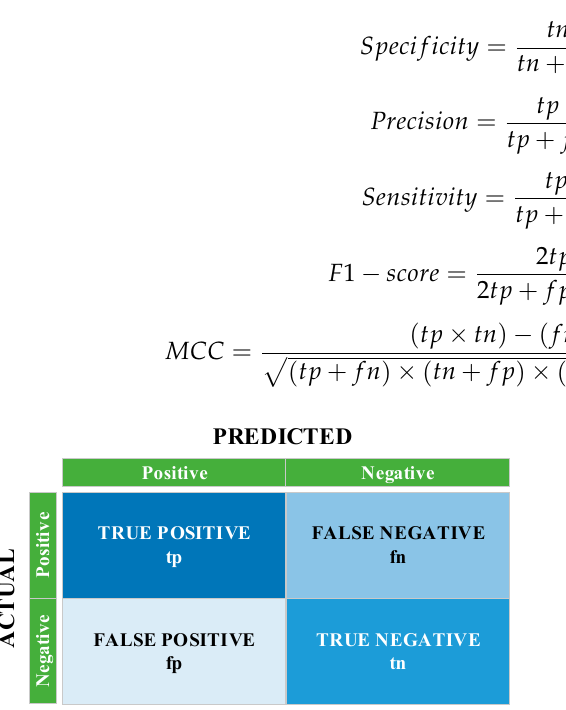
Figure 12. Structure of confusion matrices.